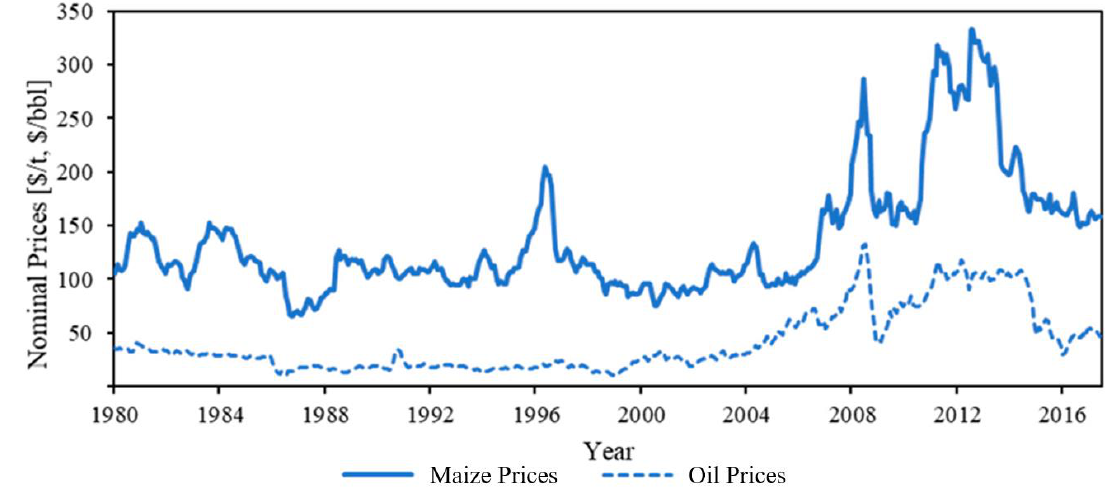
Figure 6. Connection between maize and oil prices, 1980–2017. Source: [39].